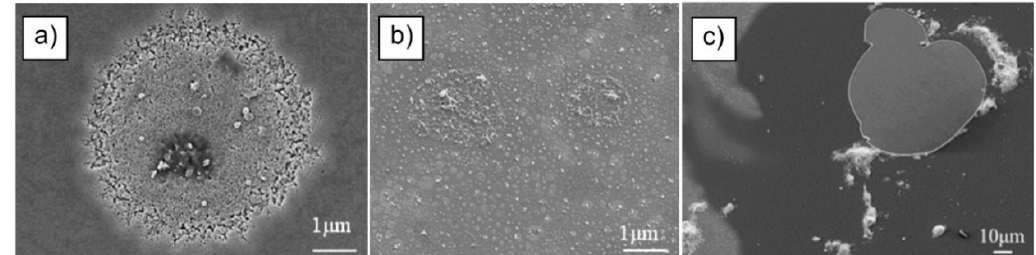
Figure 13. SEM planar view images of the coating surface showing ( a ) localized blistering and blister eruption after 400 h of DH; ( b ) blistering after 1000 h of DH, and ( c ) delamination of a coating after 1000 h of UV exposure observed on various tested coatings B and C.